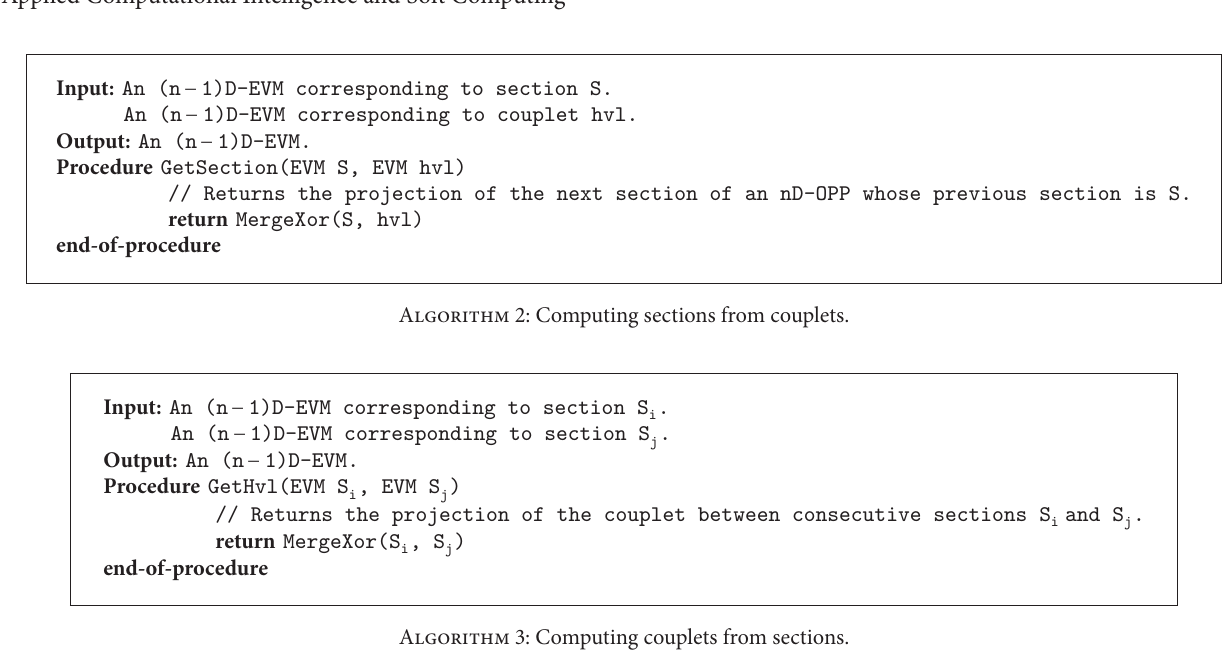
Algorithm 3: Computing couplets from